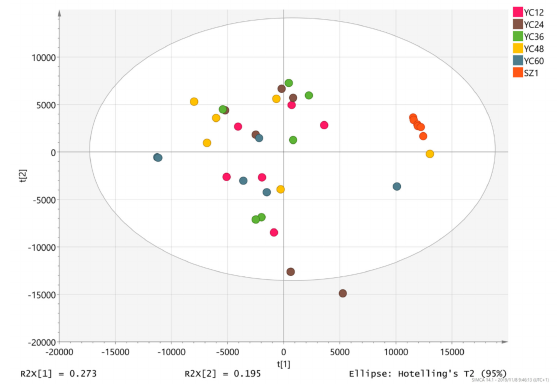
Figure 2. The 2D principal component analysis (PCA) score map.